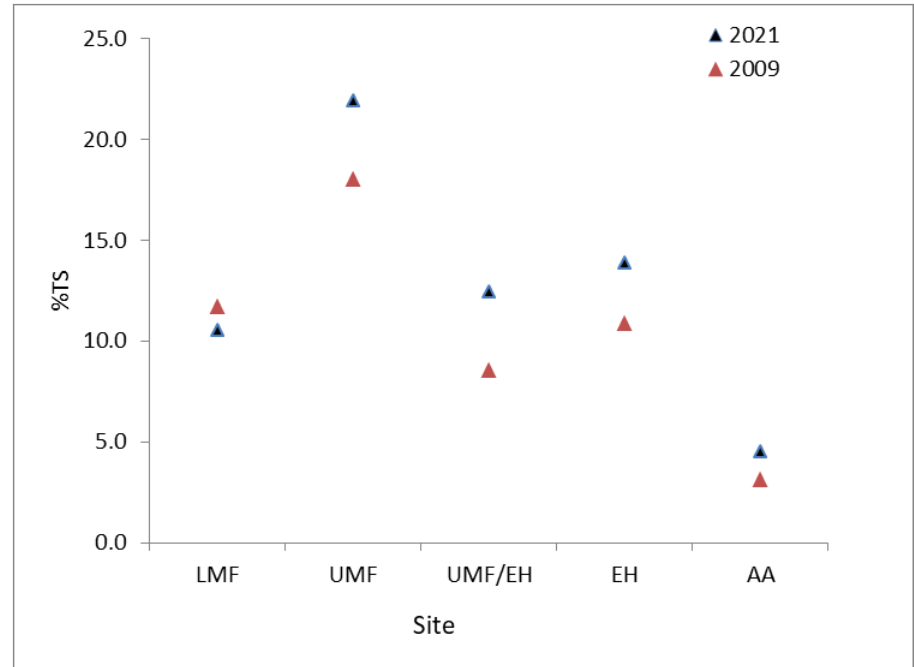
Figure 6. Percentage of trap success (%TS) between the two studies, across sites. LMF (lower montane forest); UMF (upper montane forest); UMF/EH (upper montane forest/Ericaceous heathland); EH (ericaceous heathland); and AA (Afroalpine).